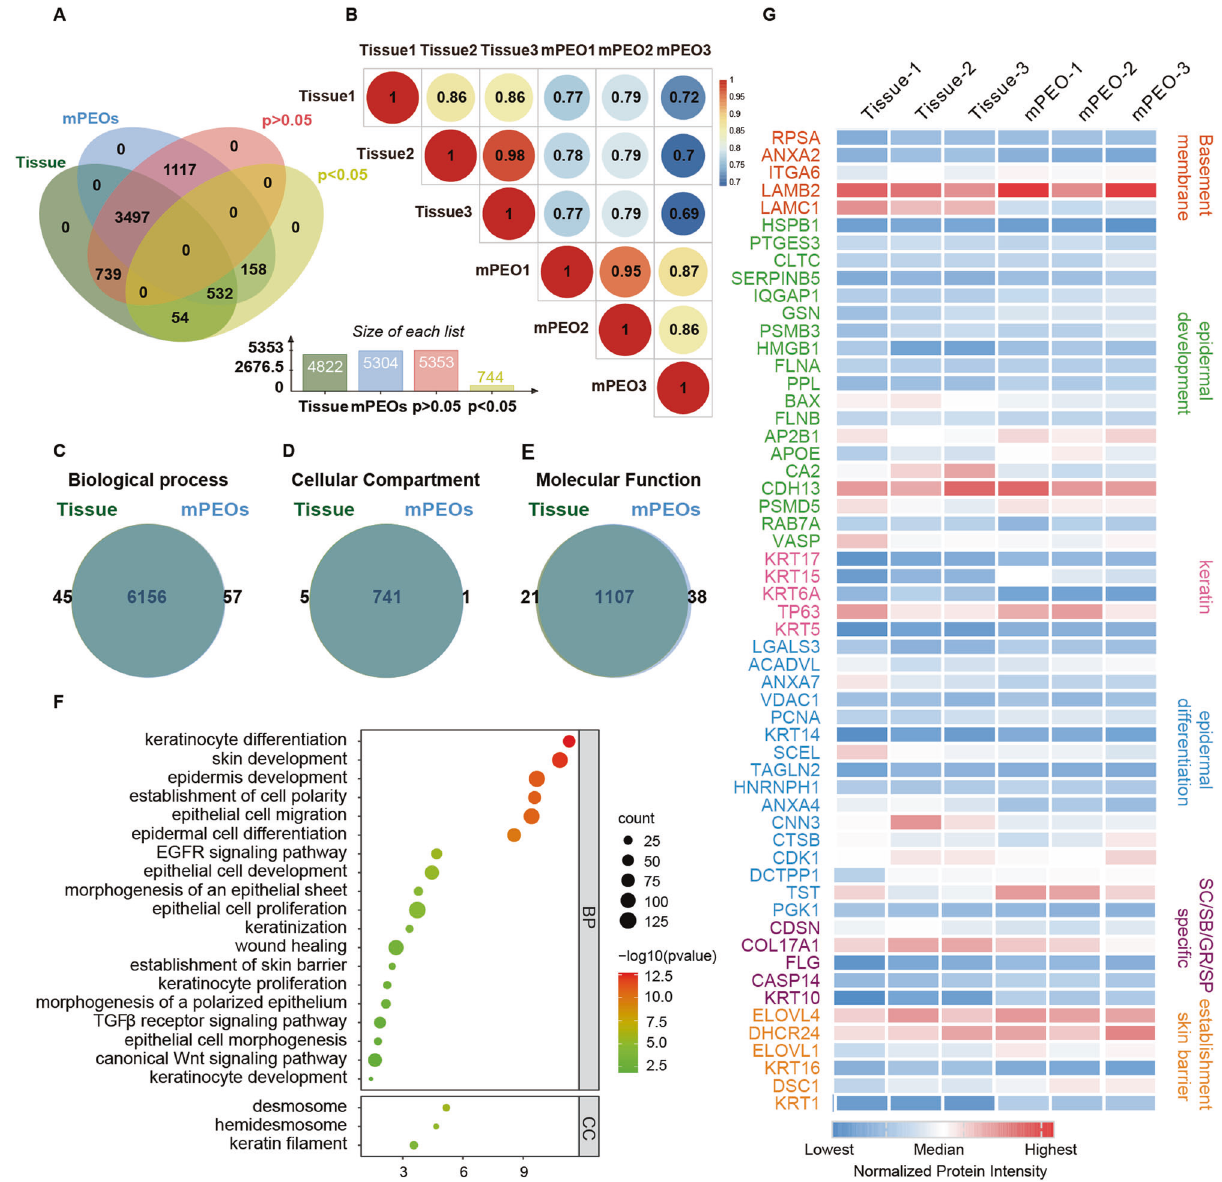
Fig. 3 Comparisons of proteomes between mPEOs and their derived skin tissue. A Venn diagram showing commonly found proteins among mPEOs and their derived skin tissues. B The Pearson correlation values of protein expression between mPEOs and tissues. Venn diagram showing the overlapping proteins between mPEOs and their derived tissues are enriched in C biological process, D cellular compartment and E molecular function. F Biological process and cellular compartment analysis of the mPEO proteomic pro fi le. G Heatmap analysis of differences in normalized intensity of proteins involved in basement membrane, epidermal development, keratin, epidermal differentiation, SC/SB/GR/SP speci fi c and establishment skin barrier in mPEOs and their derived skin